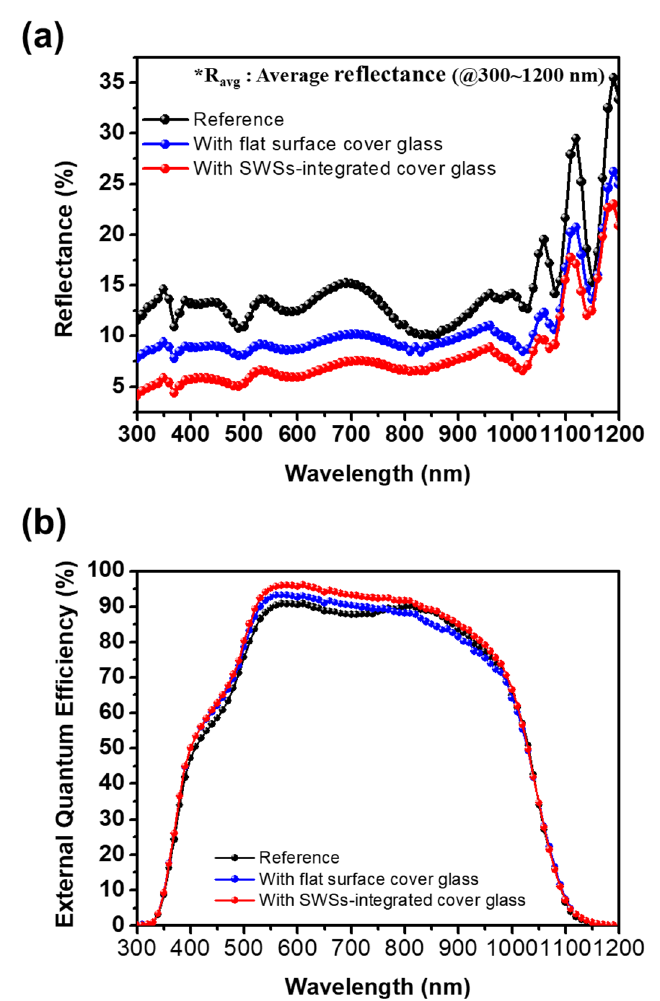
Figure 5. The measured ( a ) reflectance and ( b ) external quantum efficiency (EQE) spectra of the CIGS devices with the flat surface and the SWS-integrated cover glass, as compared with those of the reference device (without cover glass).